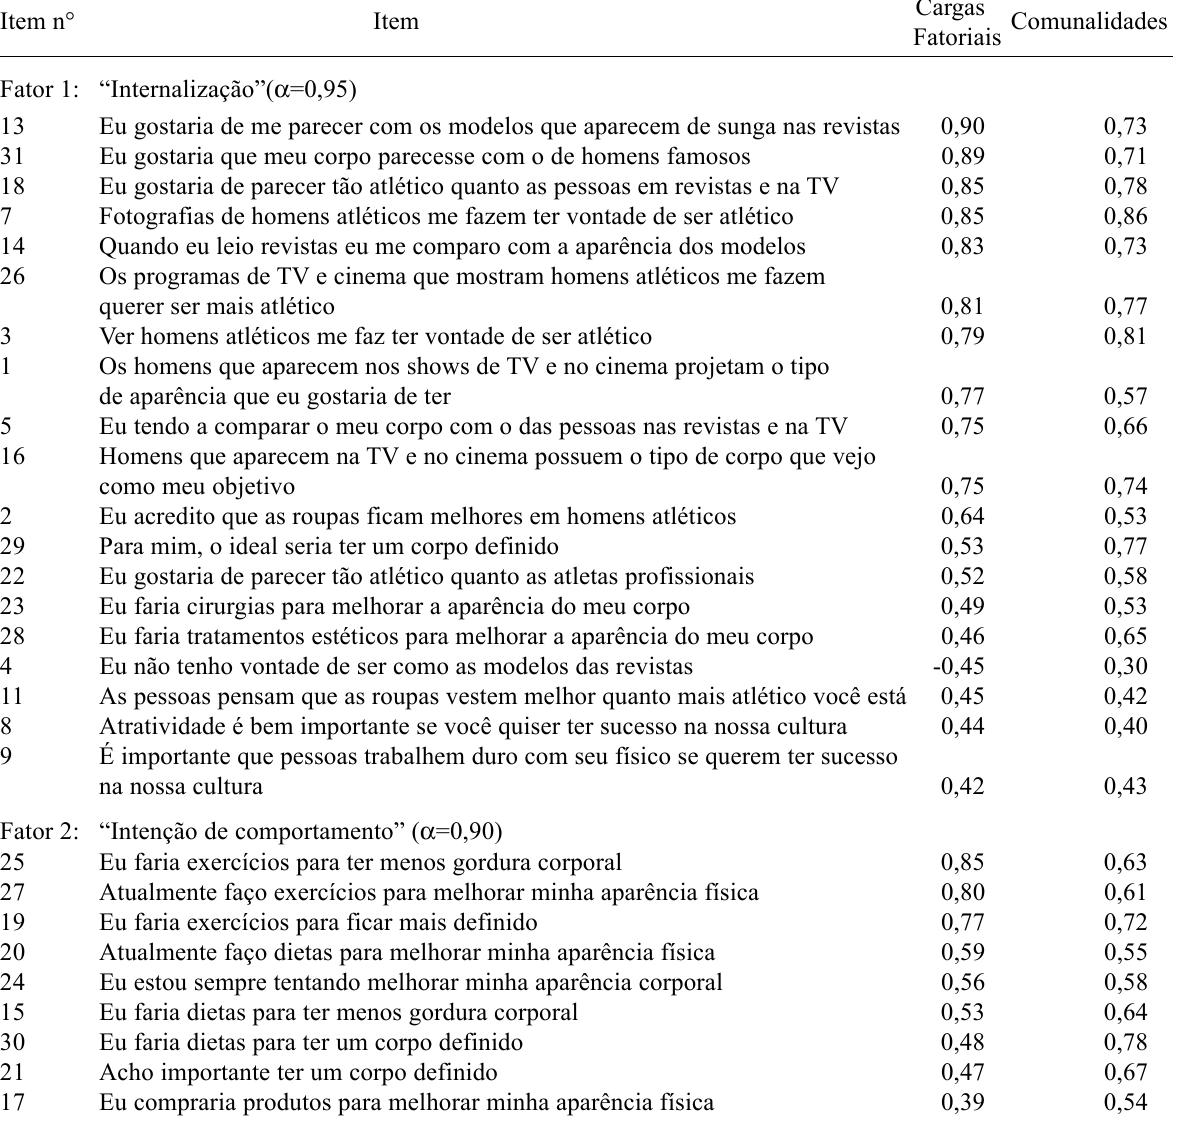
Fator 2: “Intenção de comportamento” ( α =0,90)